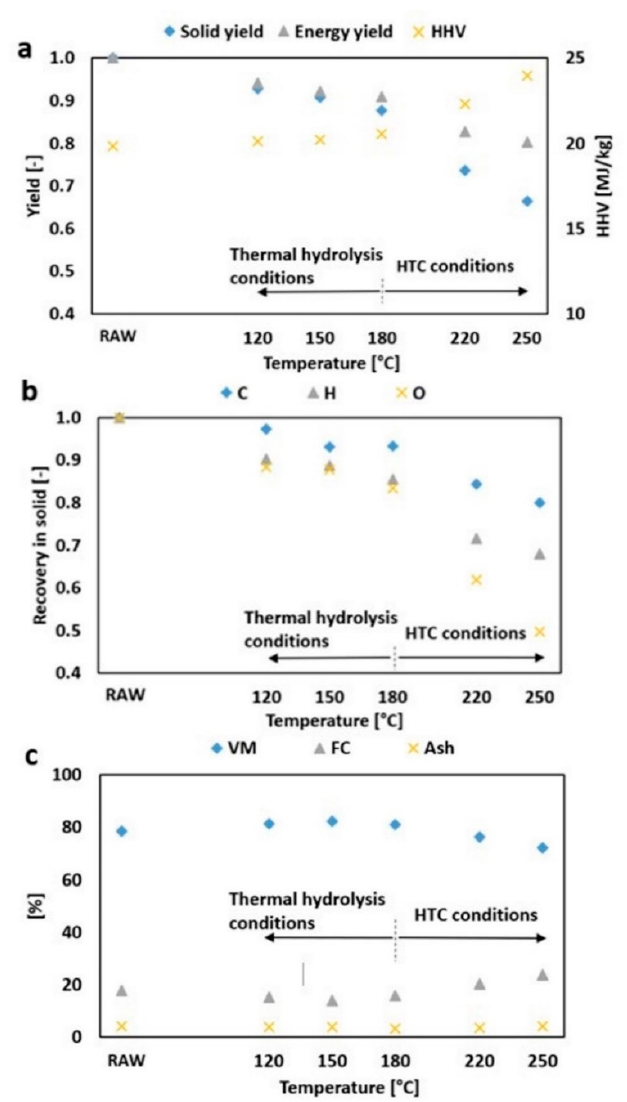
Figure 3. Transient time: ( a ) hydrochar yield, energy yield, and HHV vs. temperature; ( b ) element recovery in the hydrochar vs temperature; and ( c ) proximate analysis data vs temperature.